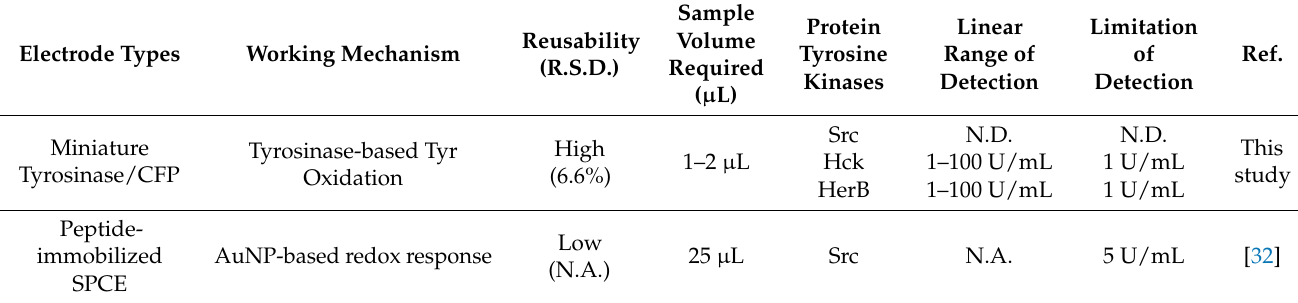
Table 1. Comparison of the performance of various tyrosine kinase